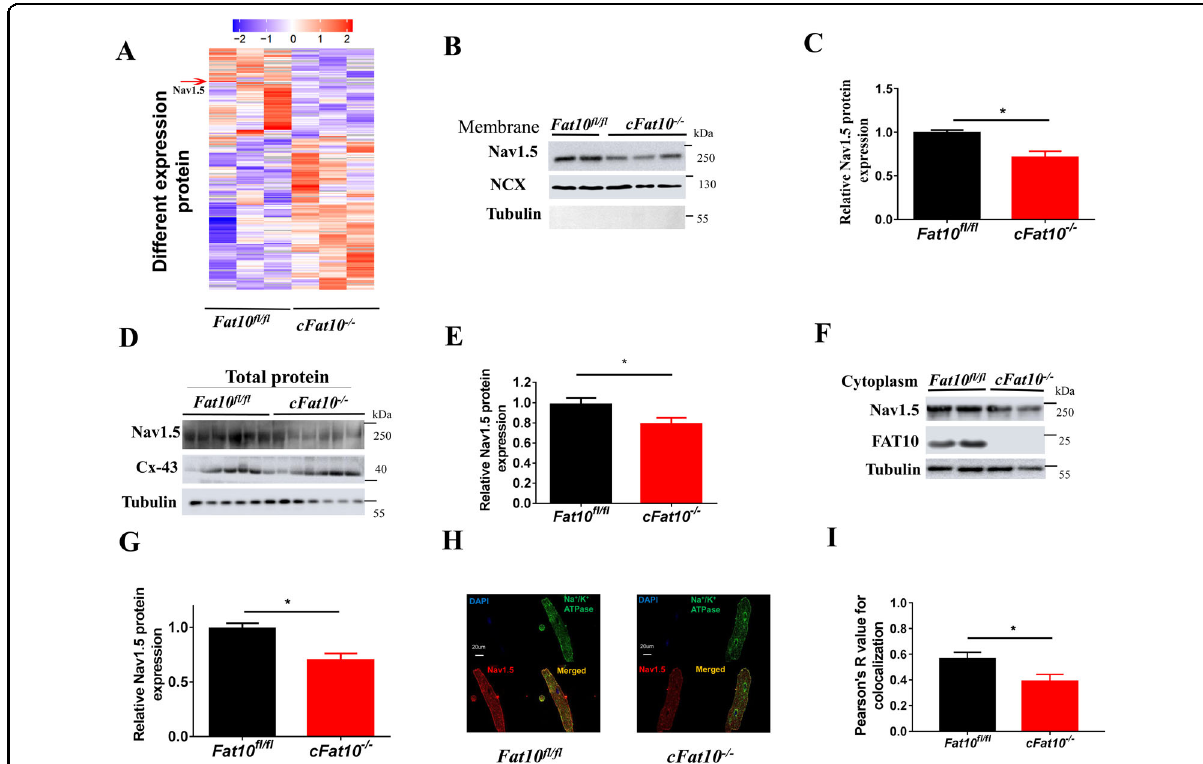
Fig. 2 Nav1.5 protein expression is reduced in F at 10 -de fi cient ventricular myocytes. A Mass spectroscopic analysis was performed to detect protein expression in heart tissue samples from Fat10 fl / fl mice ( n = 3) and cFat10 − / − mice ( n = 3). Heatmap showing the differential expression of membrane proteins. B , C Representative immunoblots ( B ) and quantitative data ( C ) of membrane Nav1.5 protein expression in heart tissues from Fat10 fl / fl and cFat10 − / − mice (* p < 0.05); NCX: Na + /Ca 2 + exchanger. D , E Representative immunoblots ( D ) and quantitative data ( E ) of total Nav1.5 protein expression in heart extracts from cFat10 − / − and Fat10 fl / fl mice as detected by WB (* p < 0.05). F , G Representative immunoblots ( F ) and quantitative data ( G ) of cytoplasmic Nav1.5 expression in heart tissues from cFat10 − / − and Fat10 fl / fl mice (* p < 0.05) as detected by WB. H , I Representative immunostaining showing the degree of colocalization between Nav1.5 and Na + /K + ATPase ( H ) and Pearson ’ s correlation coef fi cient for colocalization ( I ) in isolated cardiomyocytes (scale bar = 20 μ m). All results are expressed as the mean ± SEM of independent